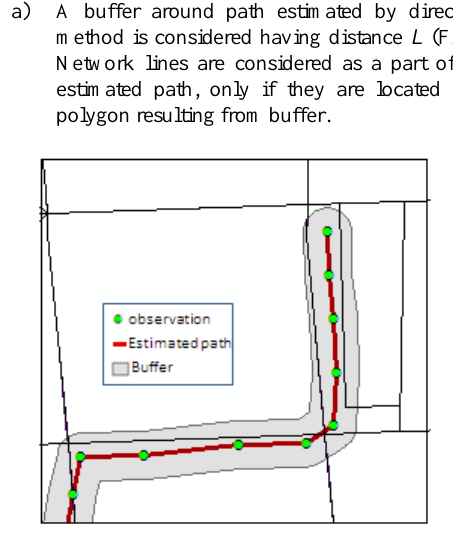
Figure 6. Buffer from estimated path using direct